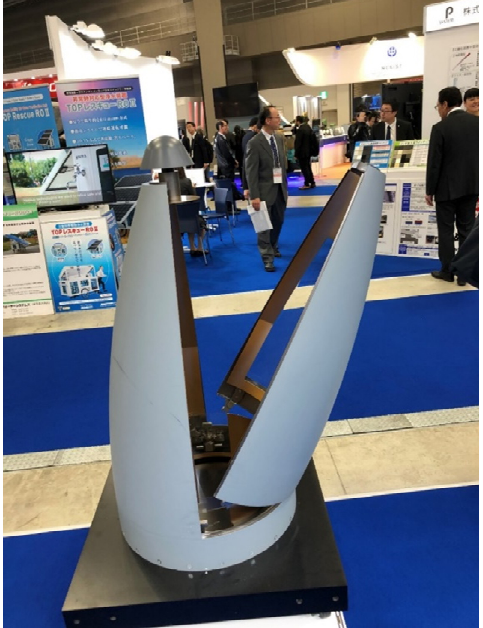
Figure 4. Large structural Ti-42Al-5Mn components exhibited at the Japan International Aerospace Exhibition 2018 Tokyo (JA2018 Tokyo).